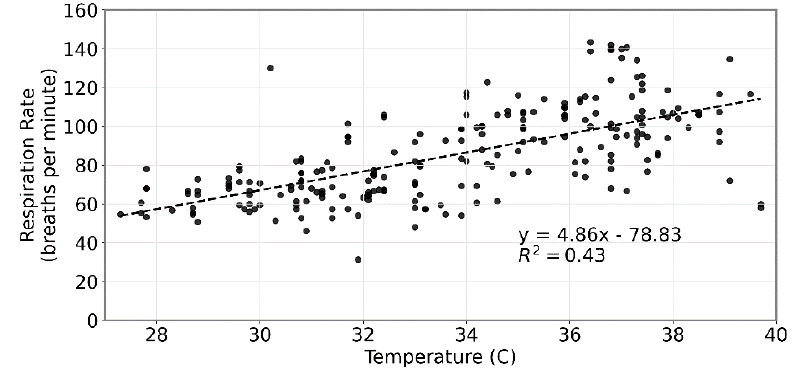
Figure 6. Respiration Rate variation with ambient temperature.